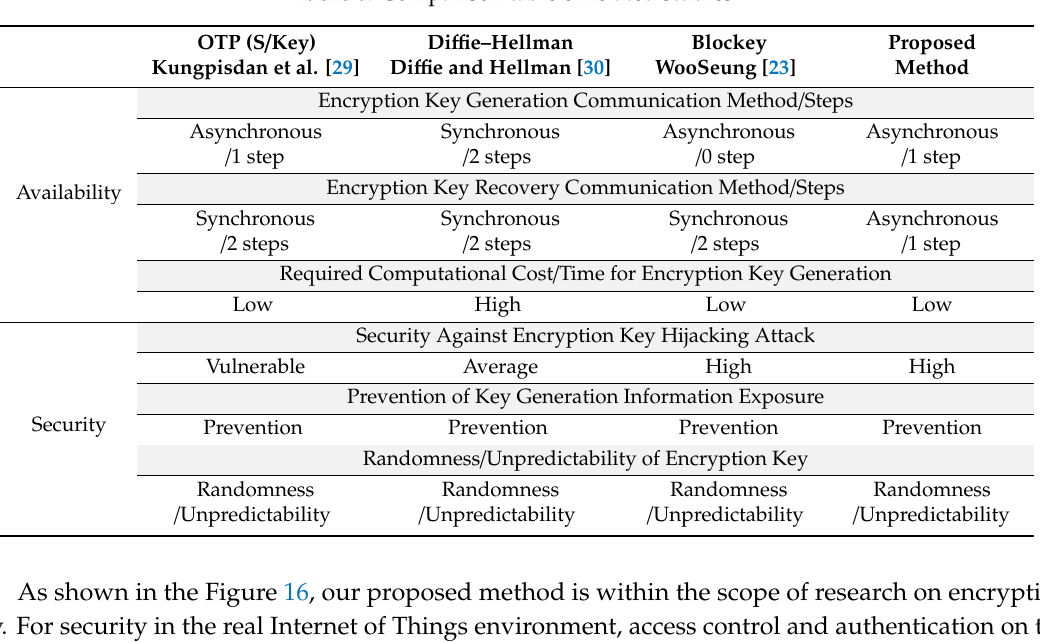
Table 6. Comparison table of related studies.